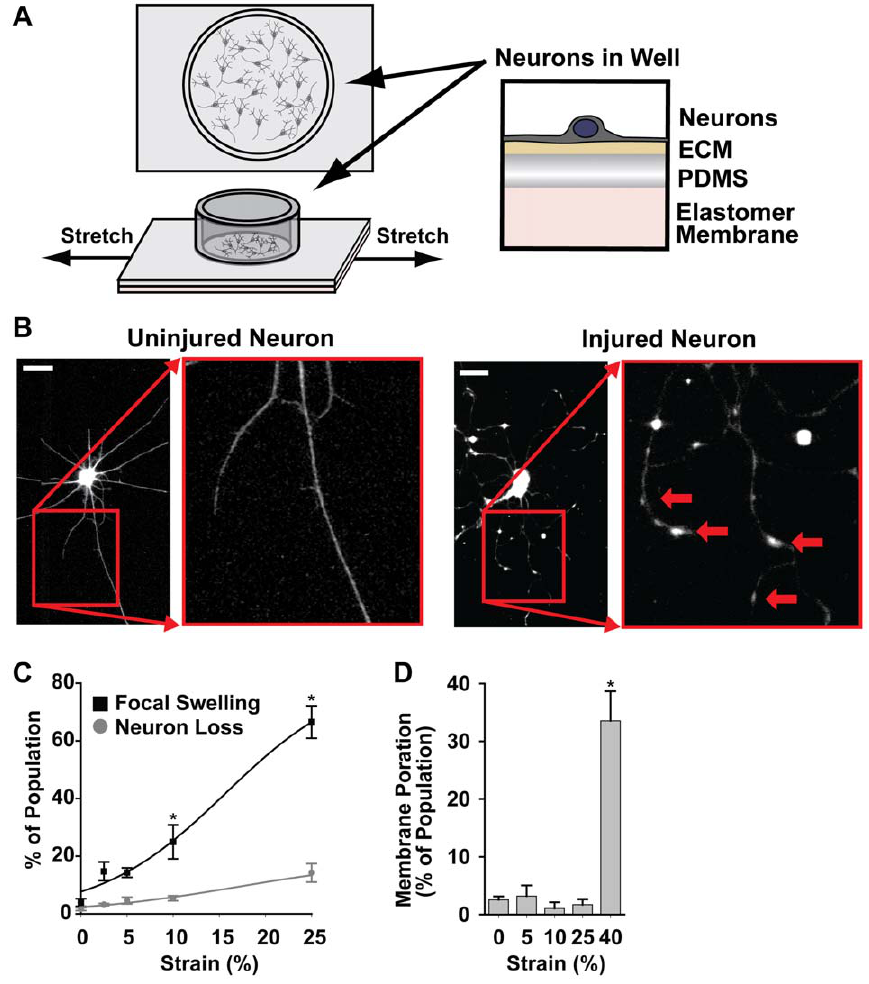
Figure 1. High speed stretch model of neuronal cultures indicates a strain dependent injury response identified by focal swelling of the neurites without porating the membrane. ( A ) Neurons were cultured on elastomer membranes that were quickly stretched, transferring injurious forces to neurons. ( B ) Beta-3-Tubulin immunofluorescence imaging showed that prior to stretch, neurons exhibited a highly branched, smooth neurite morphology. After stretch, many neurons developed widespread focal swellings along their neurites (red arrows) (Scale Bar =20 m m). ( C ) Quantification of neuronal injury showed an initial significant response between 0% and 10% strains ( n $ 4). Neuron loss due to stretch also increased with strain magnitude. ( D ) The percentage of neurons exhibiting signs of membrane poration, as indicated by the uptake of a membrane impermeable dye, following stretch showed an initial significant increase between 25% and 40% strain ( n $ 3). All bars SEM for all panels, * p , 0.05.